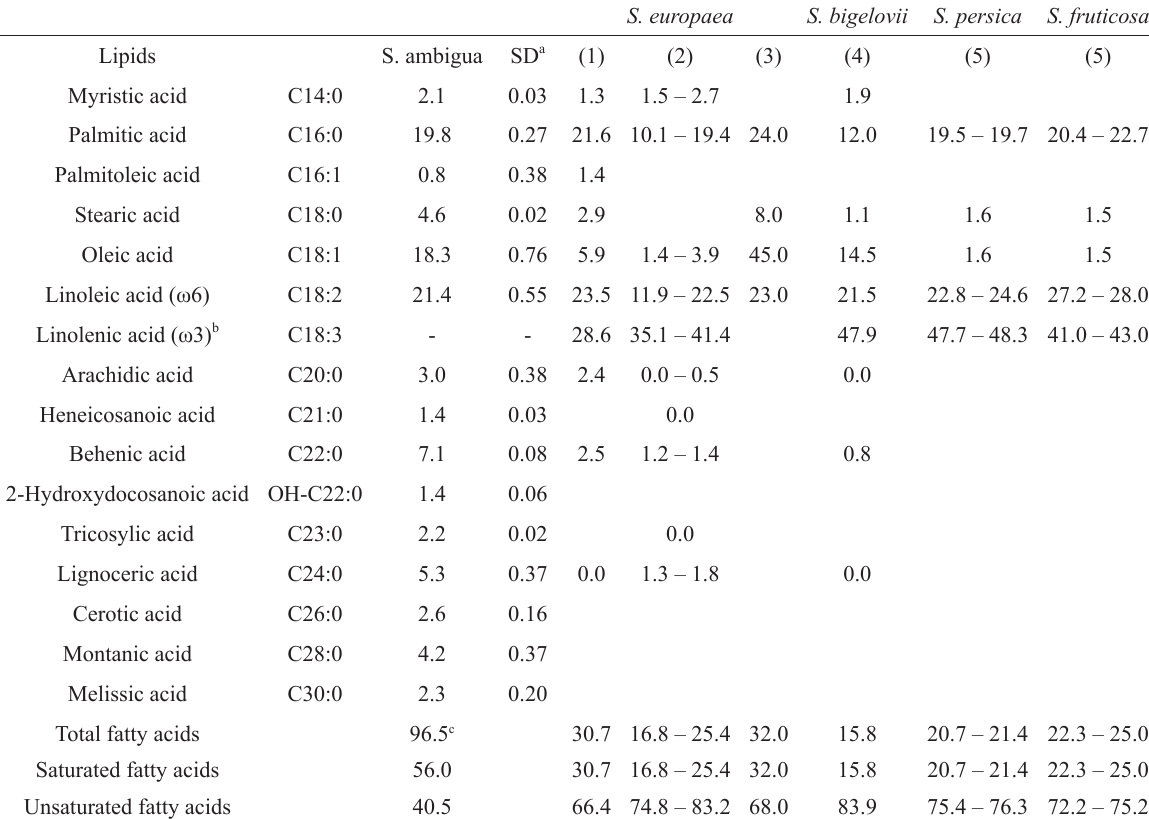
Lipid composition (%) of Sarcocornia ambigua fertile shoot meal extracted with